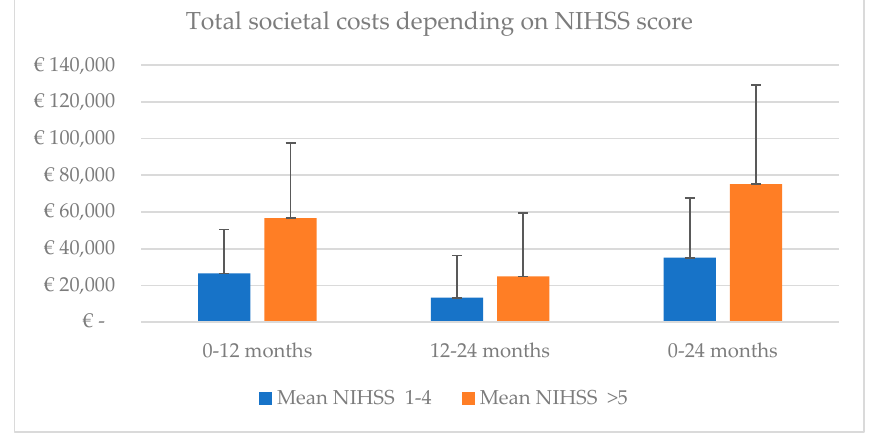
Figure 2. ( A ): subgroup analyses: mean (standard deviation) costs for discharge group, home ( n = 247, in blue) and rehabilitation clinics ( n = 48, in red), or Nursing home ( n = 49, in grey). ( B ): subgroup analyses: mean (standard deviation) costs per NIHSS scores, 1–4 (in blue) and >5 (in red). NIHSS—National Institutes of Health Stroke Scale.